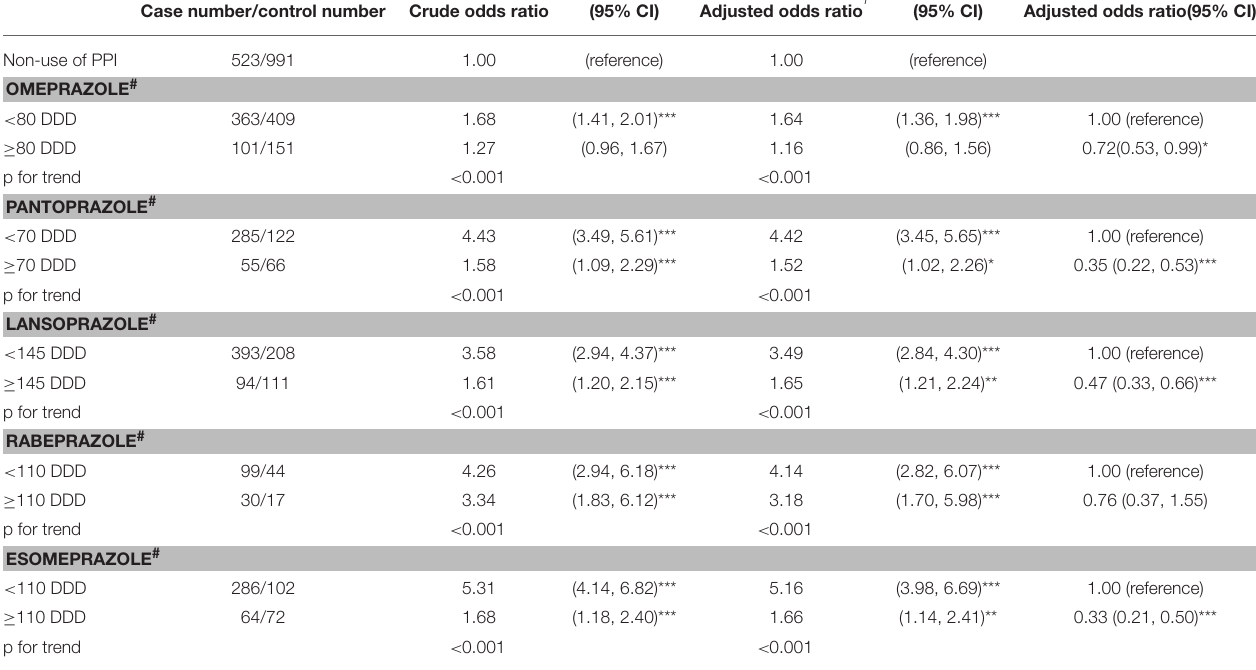
TABLE 3 | Odds ratio and 95% confidence intervals of cholangiocarcinoma associated with cumulative DDD dose of individual proton pump inhibitors. Case number/control number Crude odds ratio